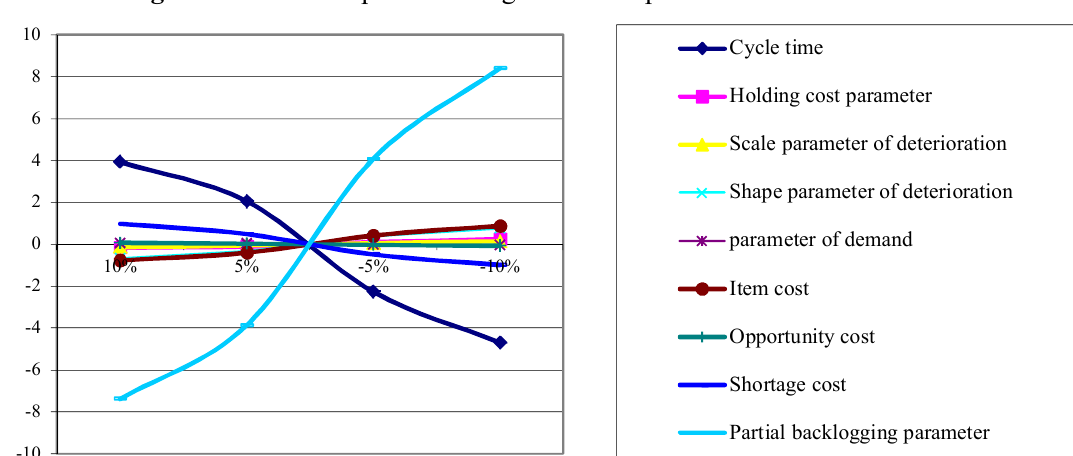
Fig. 3. Behavior of optimal average total cost per unit time in scenario 1